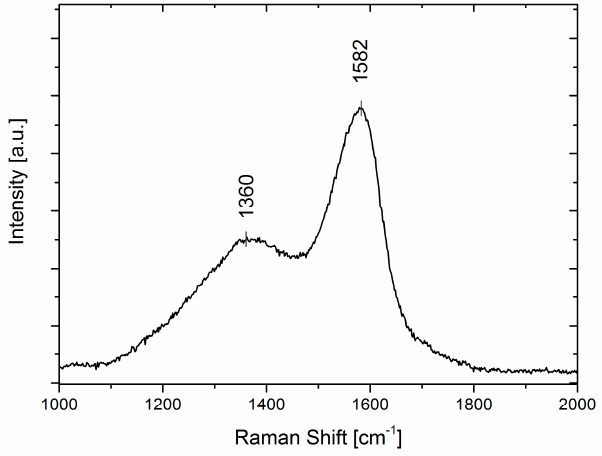
Figure 3. Raman spectrum in the wavenumber range 1000 to 2000 cm − 1 .